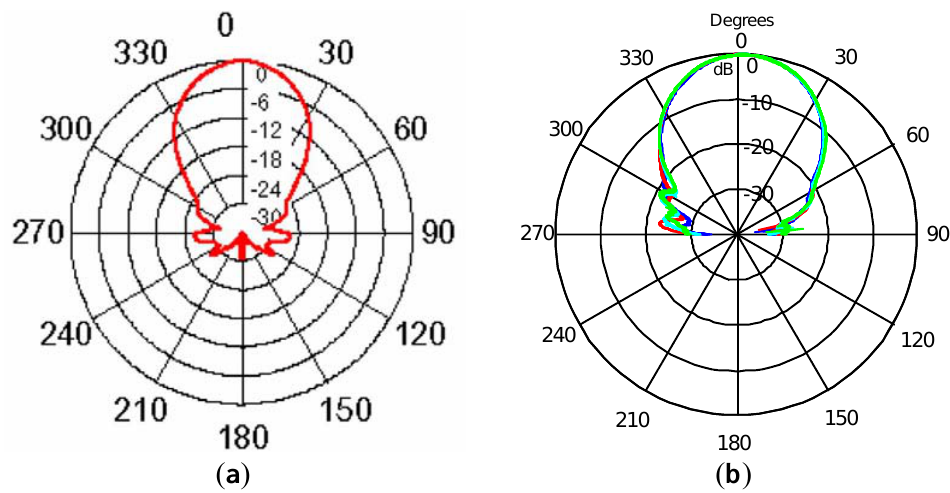
Figure 3. ( a ) Theoretical radiation pattern; ( b ) Real radiation